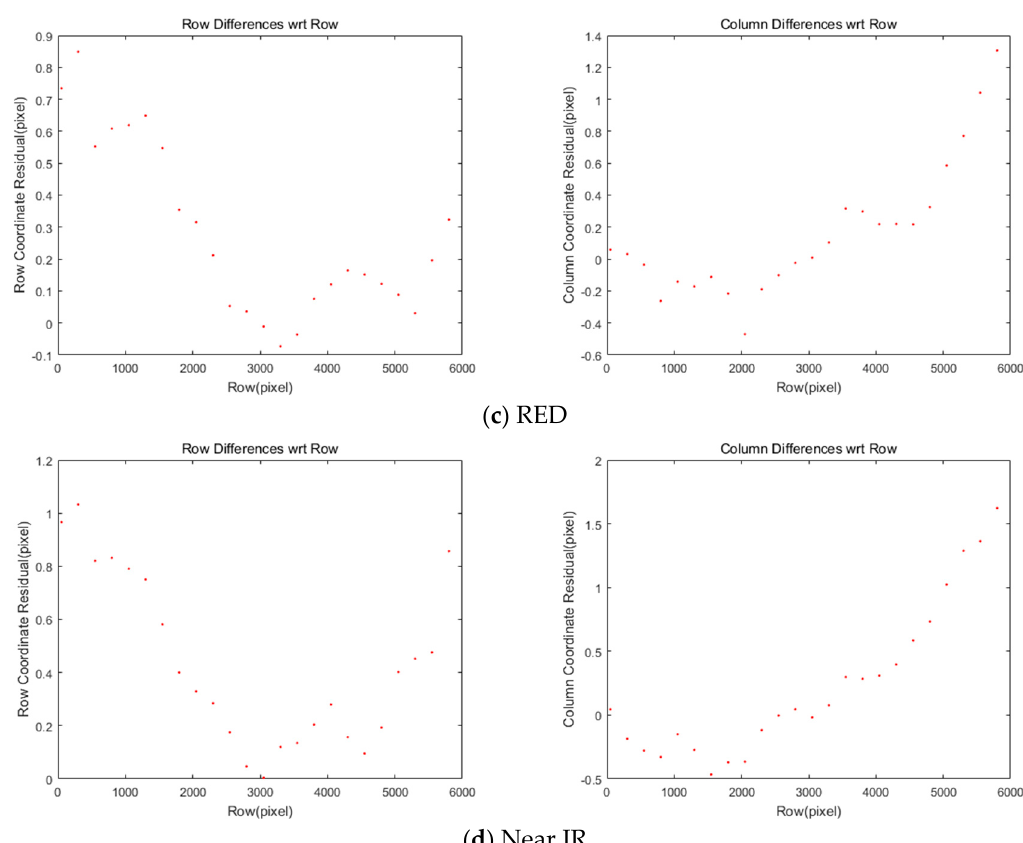
Figure 6. Differences of coordinates between MS and PAN images after CCD offset compensation.